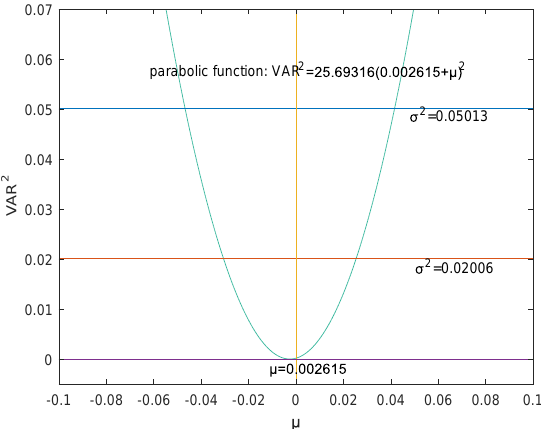
Figure 14. The joint confidence region of ( µ , VaR 2 ) when α =